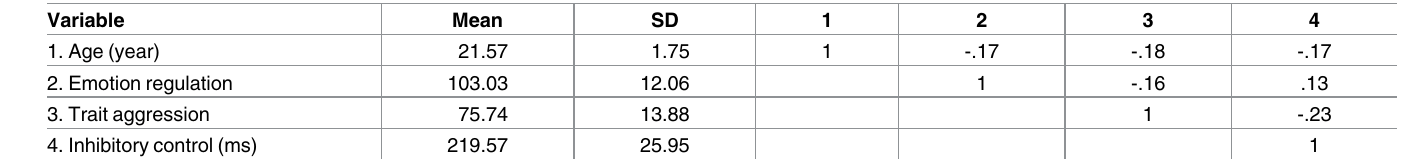
Table 1. Descriptiveresults and correlation matrix between